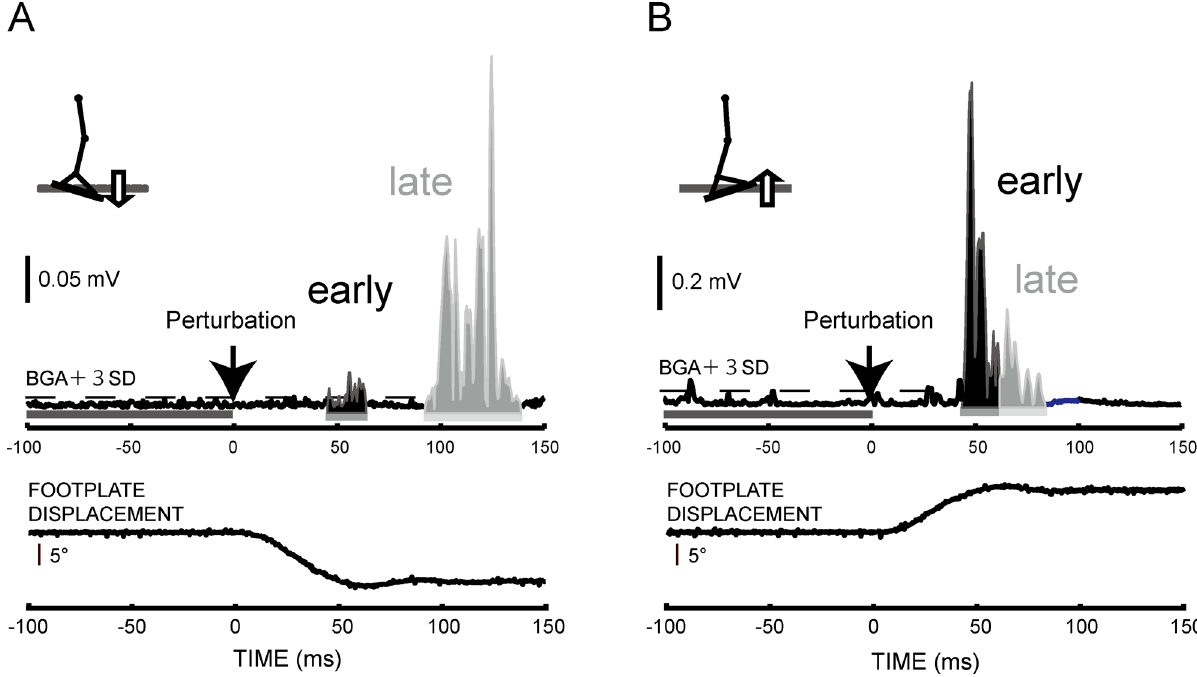
Fig 1. A typical example of the stretch reflex responses divided into the early and late responses. (A) In the TA responses to toes- down rotations. (B) In the SOL responses to toes-up rotations. The dashed horizontal line shows the threshold (BGA + 3SD) of each SR response. The black bar indicates the calculated period for BGA. The arrow indicates the onset of perturbation.